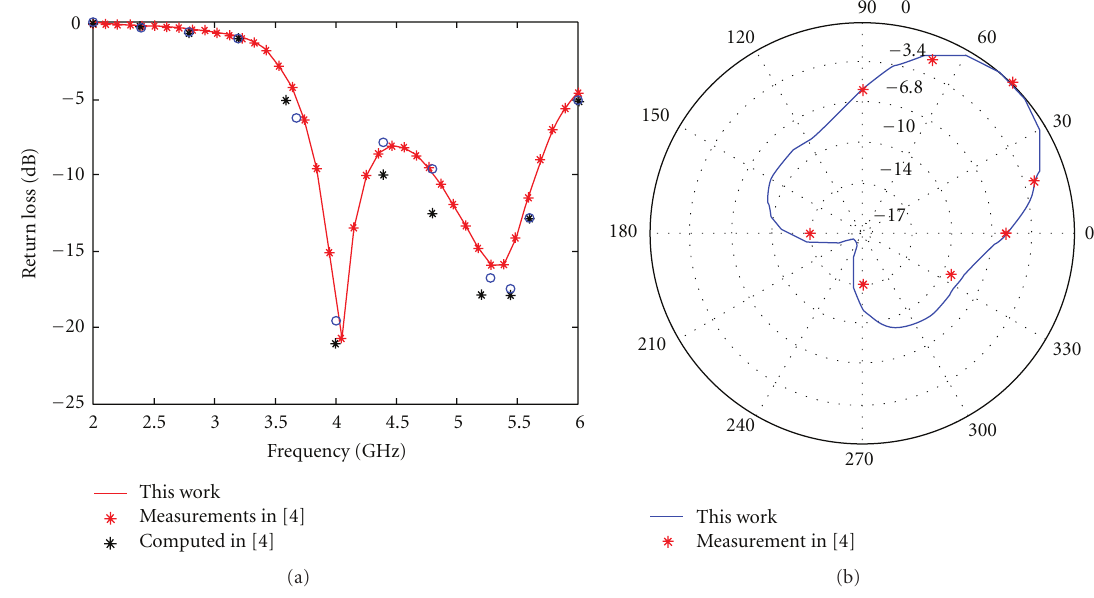
Figure 3: (a) Reflection coe ffi cient; (b) the azimuthal radiation pattern; both at